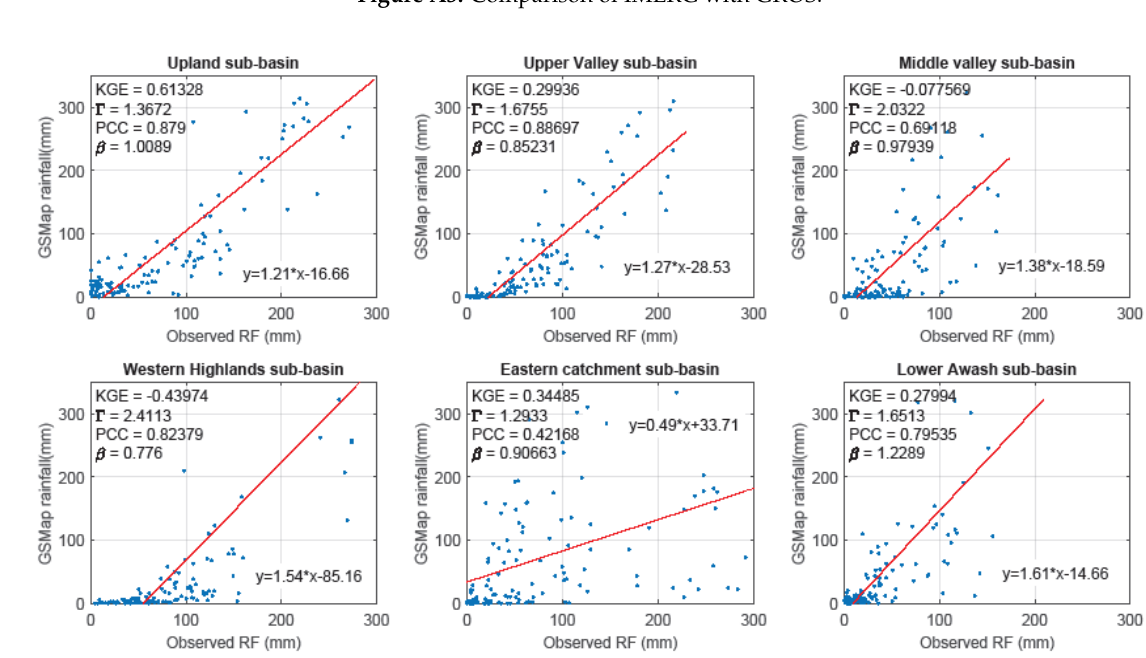
Figure A3. Comparison of IMERG with GROS.